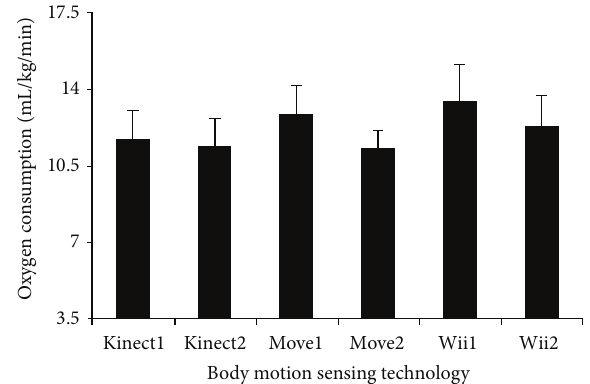
Figure 3: Oxygen consumption (standardised between subjects by expressing it in terms of mL per minute per kg body mass) during each of the different dance routines using the various different body motion sensing technologies. Data are shown as mean ( 𝑛 = 9 ) and error bars indicate SEM.